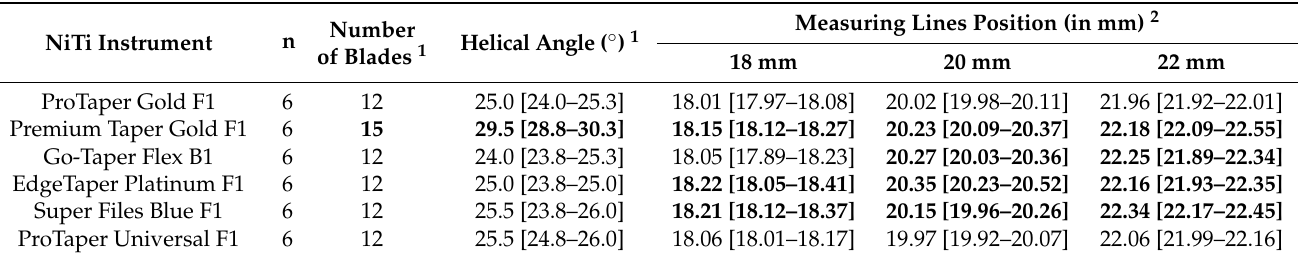
Table 2. Stereomicroscopic assessment of instruments (median and interquartile